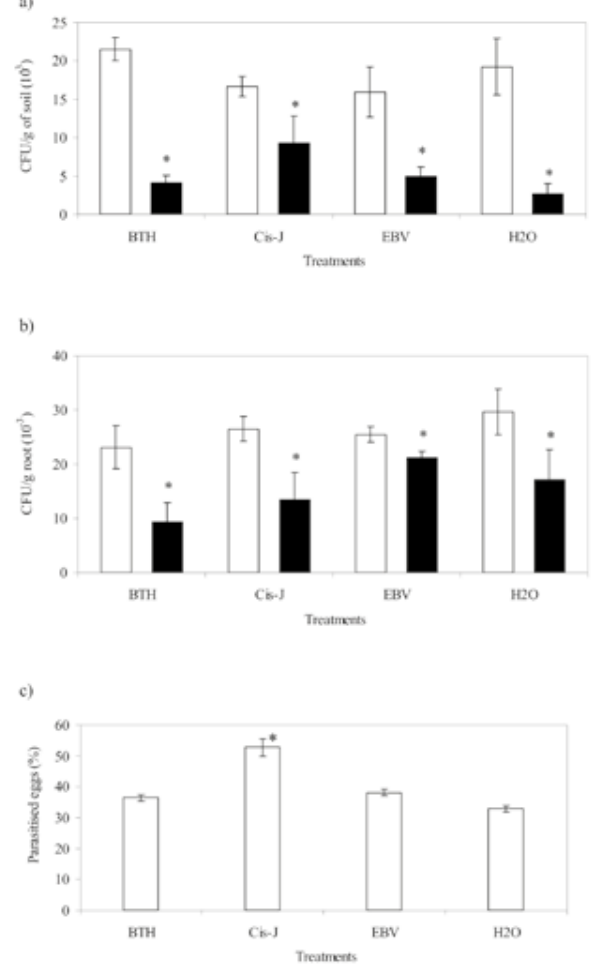
Figure 1. Mean numbers of colony forming units (cfu) of Po- chonia chlamydosporia in soil (a) and roots (b) of potato, So- lanum tuberosum , cv. Désirée and (c) egg parasitism. Treat- ments: foliar sprays of: 2.5 mM benzothiadiazole (BTH); 1 mM cis- jasmone (Cis-J); 0.1% ethoxylated nonylphenol (EBV); or water (H 2 O). (  ) inoculated with 300 Meloido- gyne chitwoodi second-stage juveniles and (  ) without the nematode. Bars represent standard error of means. *Sig- nificantly different according to Fisher LSD test ( P